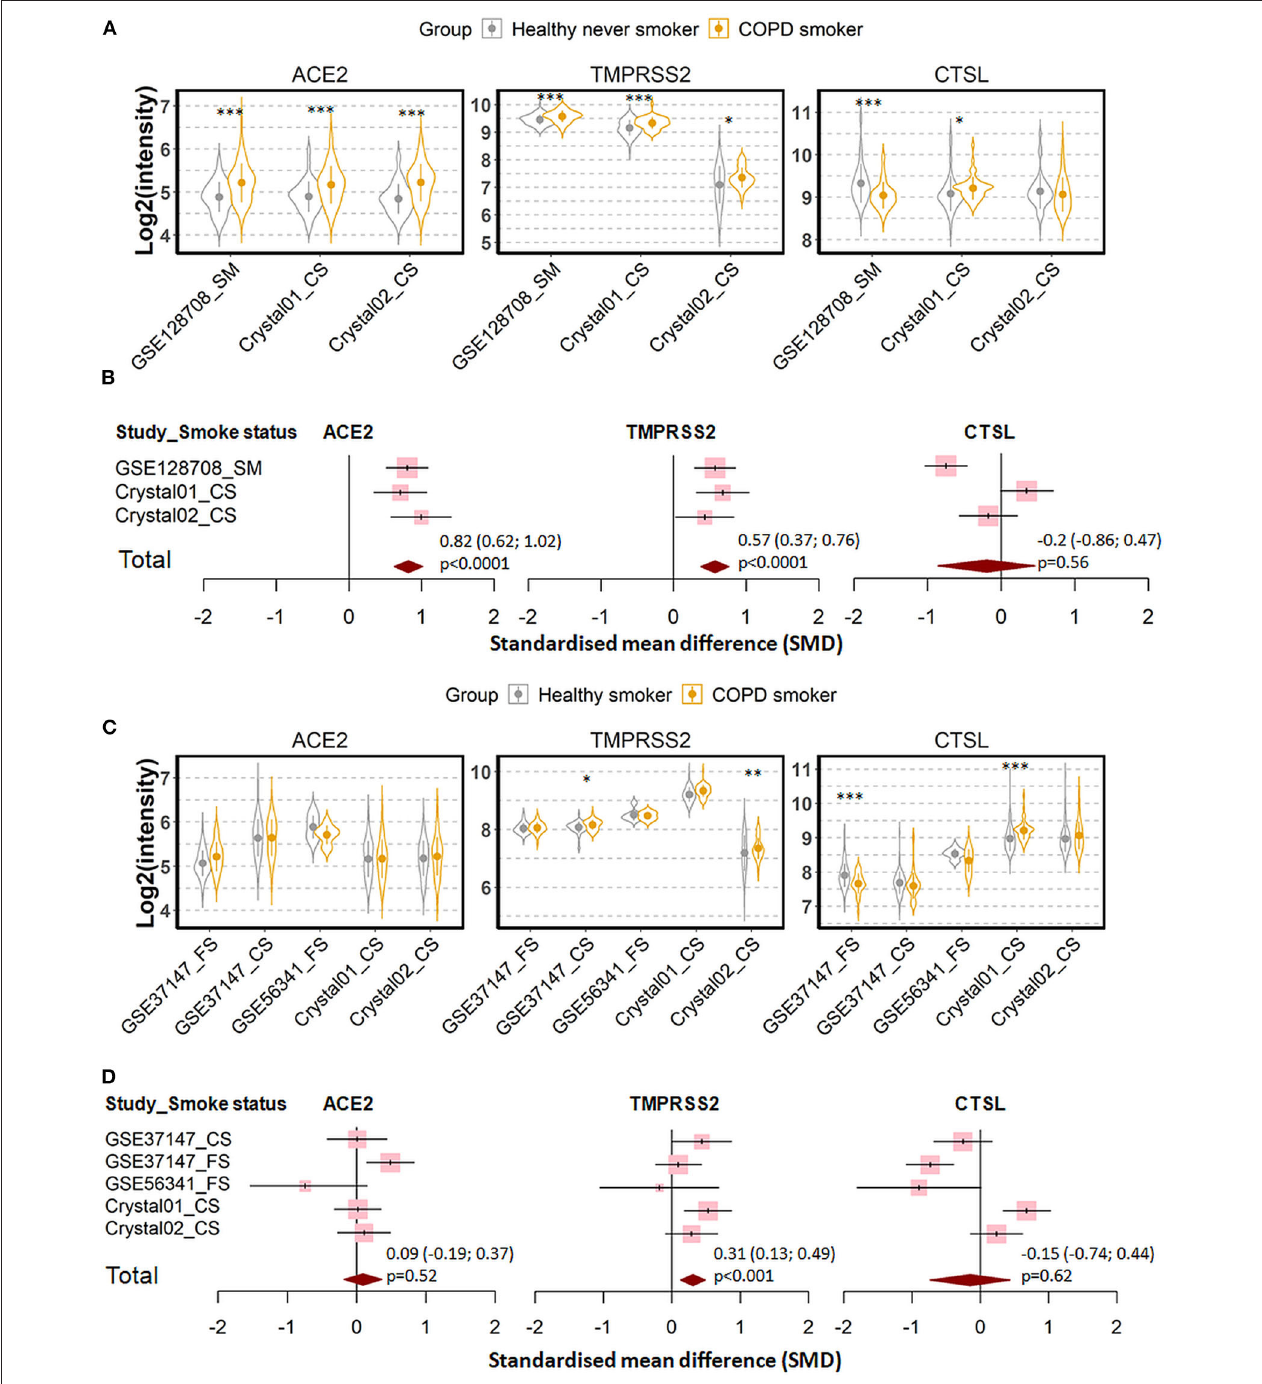
FIGURE 5 | Expression of ACE2, TMPRSS2, and cathepsin L (CTSL) in airway epithelial cells of healthy subjects and COPD patients. (A) Violin plot of expression levels of ACE2, TMPRSS2, and CTSL in three datasets which contain healthy never smokers and patients with COPD. Statistical difference was calculated by Student’s t -test. * p < 0.05, ** p < 0.01, *** p < 0.001. (B) Forest plot of three datasets examining expression of ACE2, TMPRSS2, and CTSL in healthy never smokers and patients with COPD. The SMD, 95% CI and P values of meta-analysis are depicted. (C) Violin plot of expression levels of ACE2, TMPRSS2, and CTSL in five datasets which contain healthy smokers and patients with COPD. (D) Forest plot of five datasets examining expression of ACE2, TMPRSS2, and CTSL in healthy smokers and patients with COPD. CS, Current smokers; FS, Former smokers.